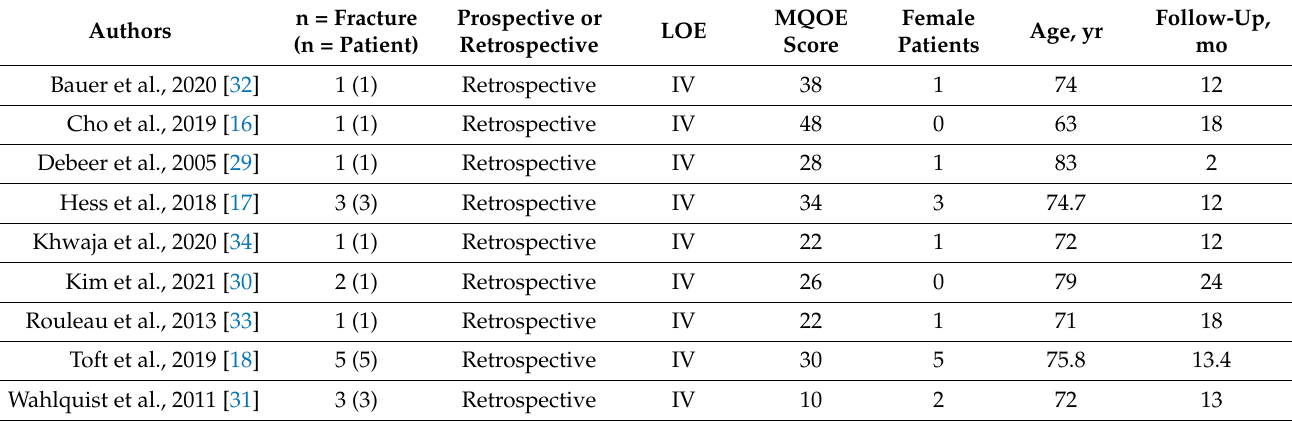
Table 1. Study Characteristics and Patient Demographic